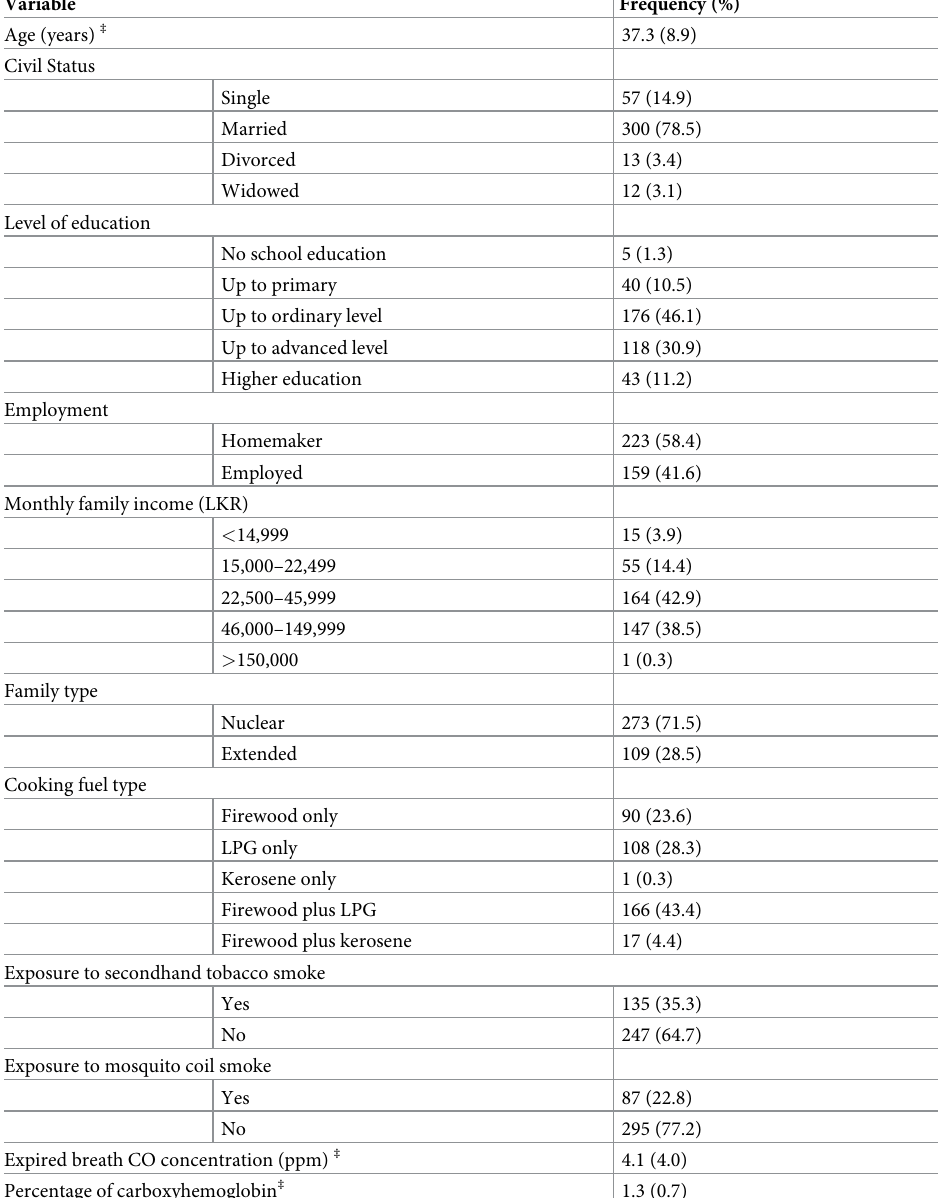
Table 1. Characteristics of the study